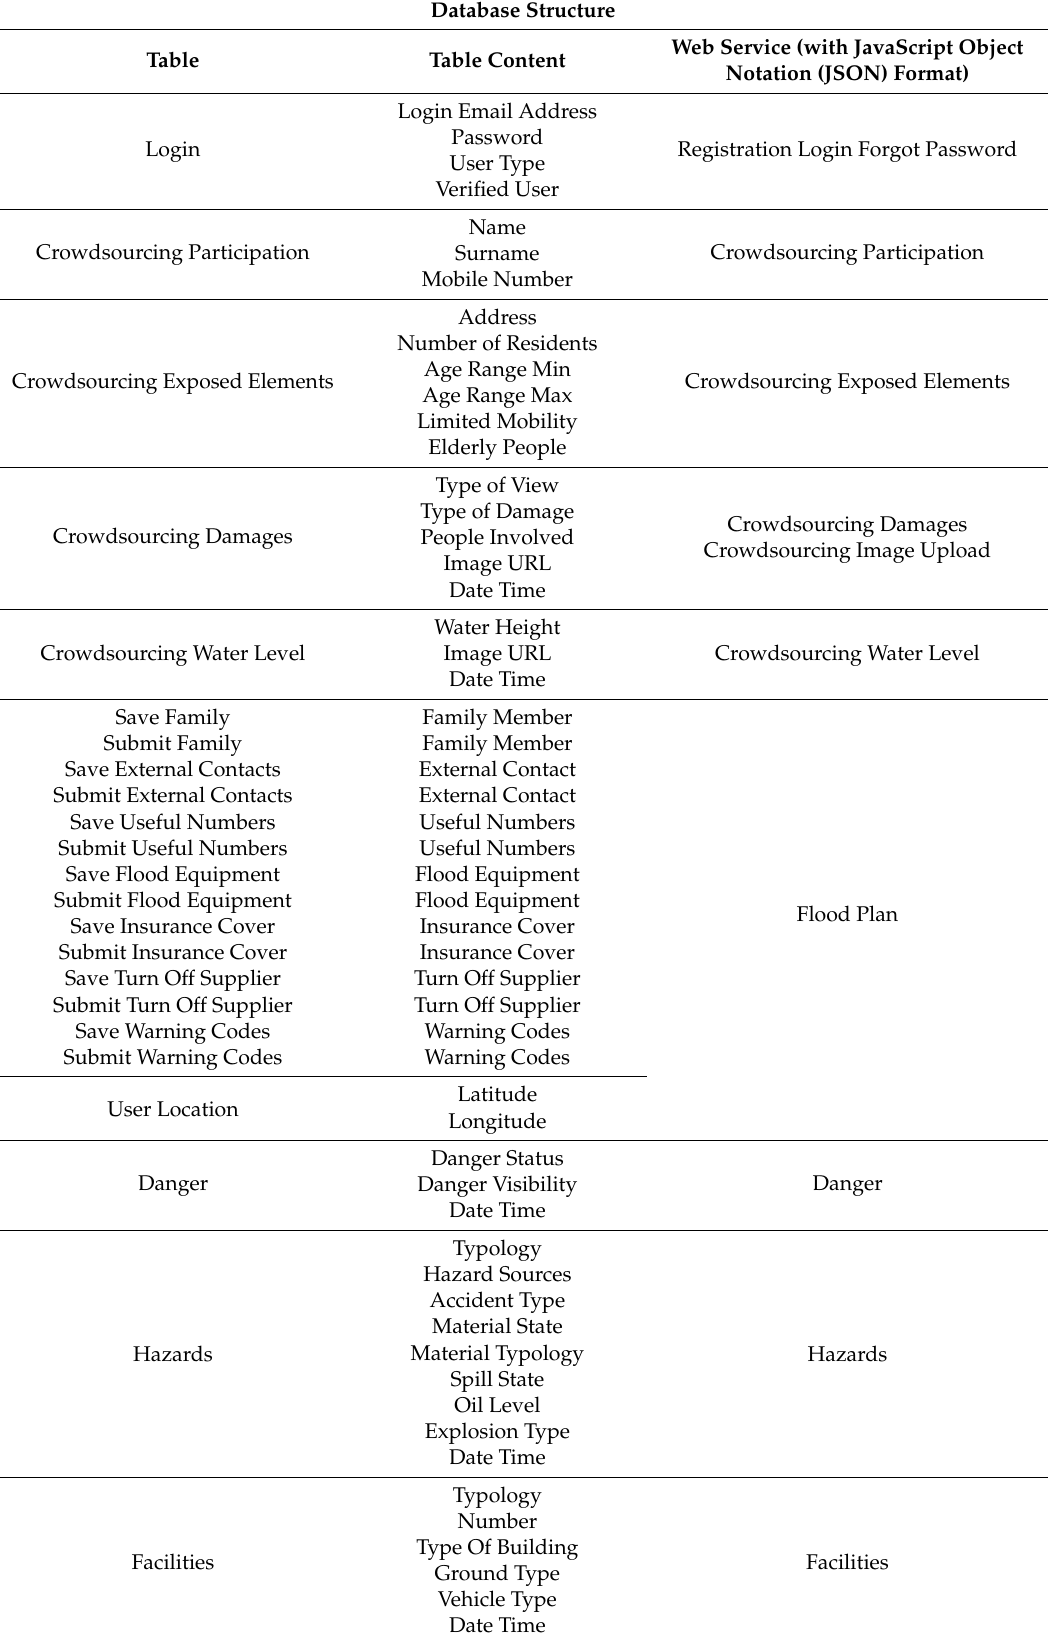
Table 2. Complete database type, organized with table, content, and web services. Database